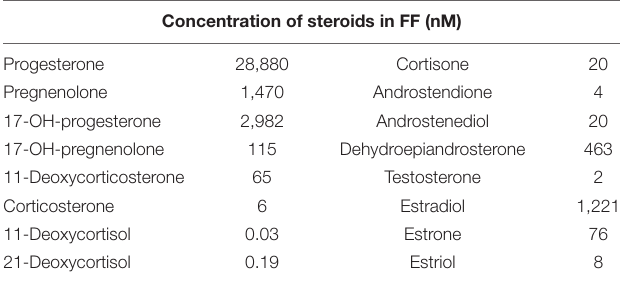
TABLE 1 | Steroid composition of pooled human follicular fluid. Concentration of steroids in FF